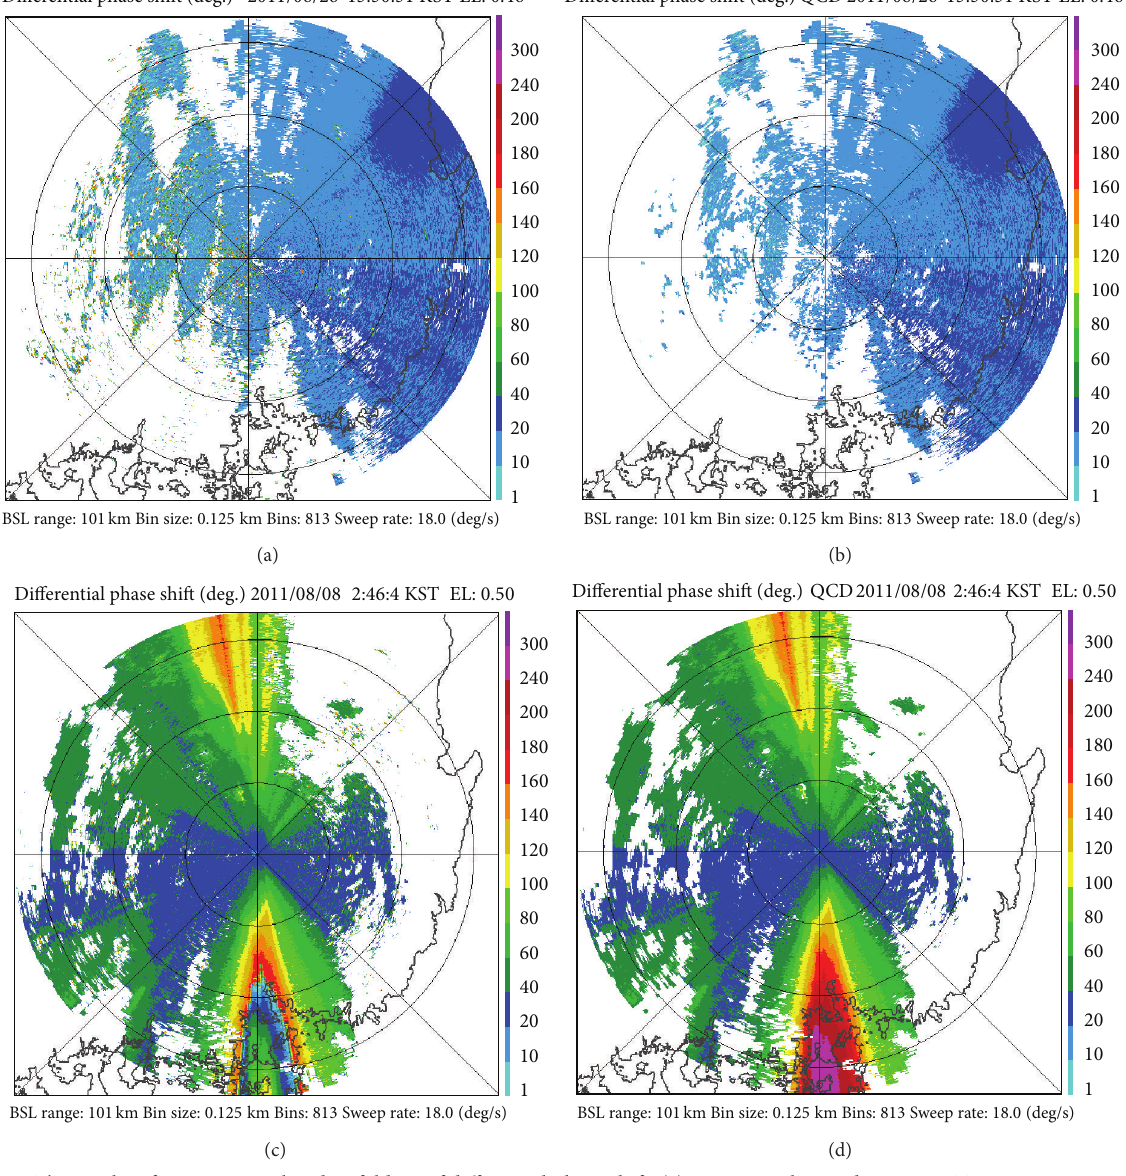
observed at 1330 LST on June 26, 2011, before DP observed at 0246 LST on August 8, 2011, before unfolding and (d) after DP